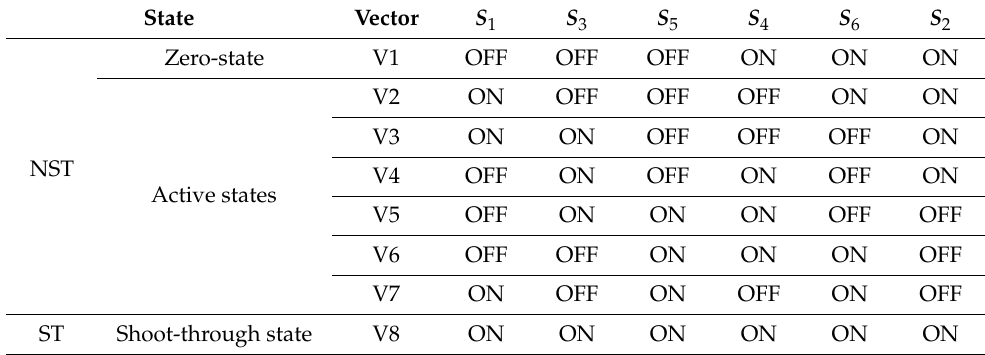
Figure 1. Modulated FCS-MPC scheme of PMSM with qZSI. Table 1. Possible switching states of qZSI.